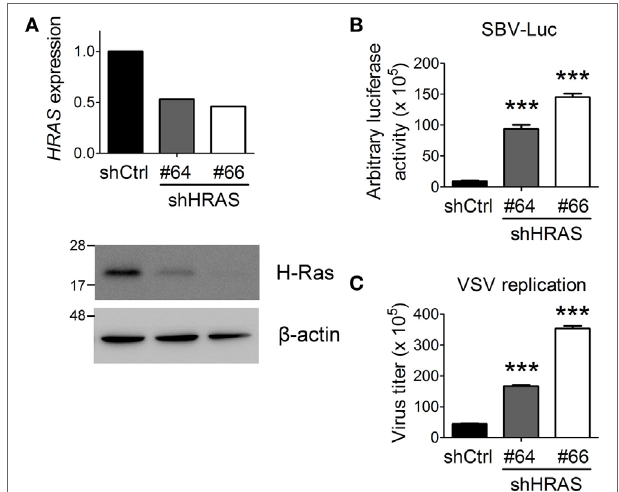
FigUre 1 | H-Ras depletion enhances the replication of two RNA viruses. (a) H-Ras in HEK293T cells was depleted by two independent lentiviral clones, shHRAS#64 and shHRAS#66, which contained shRNAs targeting HRAS . RT-qPCR and Western blot were performed to validate the knockdown efficiency of these two shRNAs. (B) HEK293T cells were treated with lentiviruses containing control shRNA (shCtrl) or shHRAS#64 or #66 for 4 days. The cells were then infected with a recombinant Sindbis virus containing a luciferase gene (SBV-Luc) at a multiplicity of infection (MOI) of 30. The expression of the luciferase gene was under the control of a subgenomic RNA promoter, which is relied on viral replication. Luciferase activity was measured at 48 h post SBV infection. (c) The HEK293T cells depleted of H-Ras by shHRAS#64 or #66 were infected with vesicular stomatitis virus (VSV) at an MOI of 0.001. The medium was harvested at 24 h post-viral infection, and the VSV titer in the supernatant was determined by plaque assays on Vero cells. All data are presented as the mean ± SD of triplicate samples from one representative of at least three independent experiments. *** P < 0.001 between the indicated groups and the control shRNA-treated group (one-way ANOVA followed by Dunnett’s post hoc